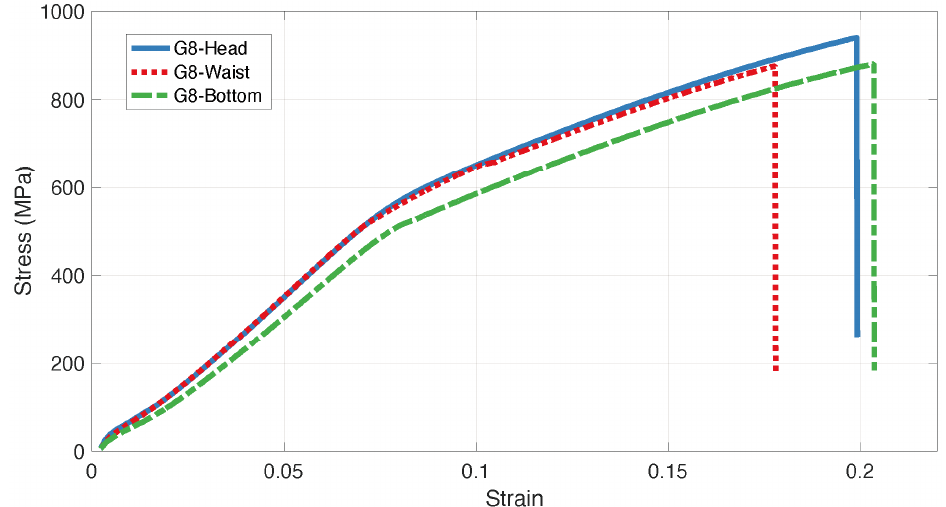
Figure 10. The strain–stress curves of Group 8.